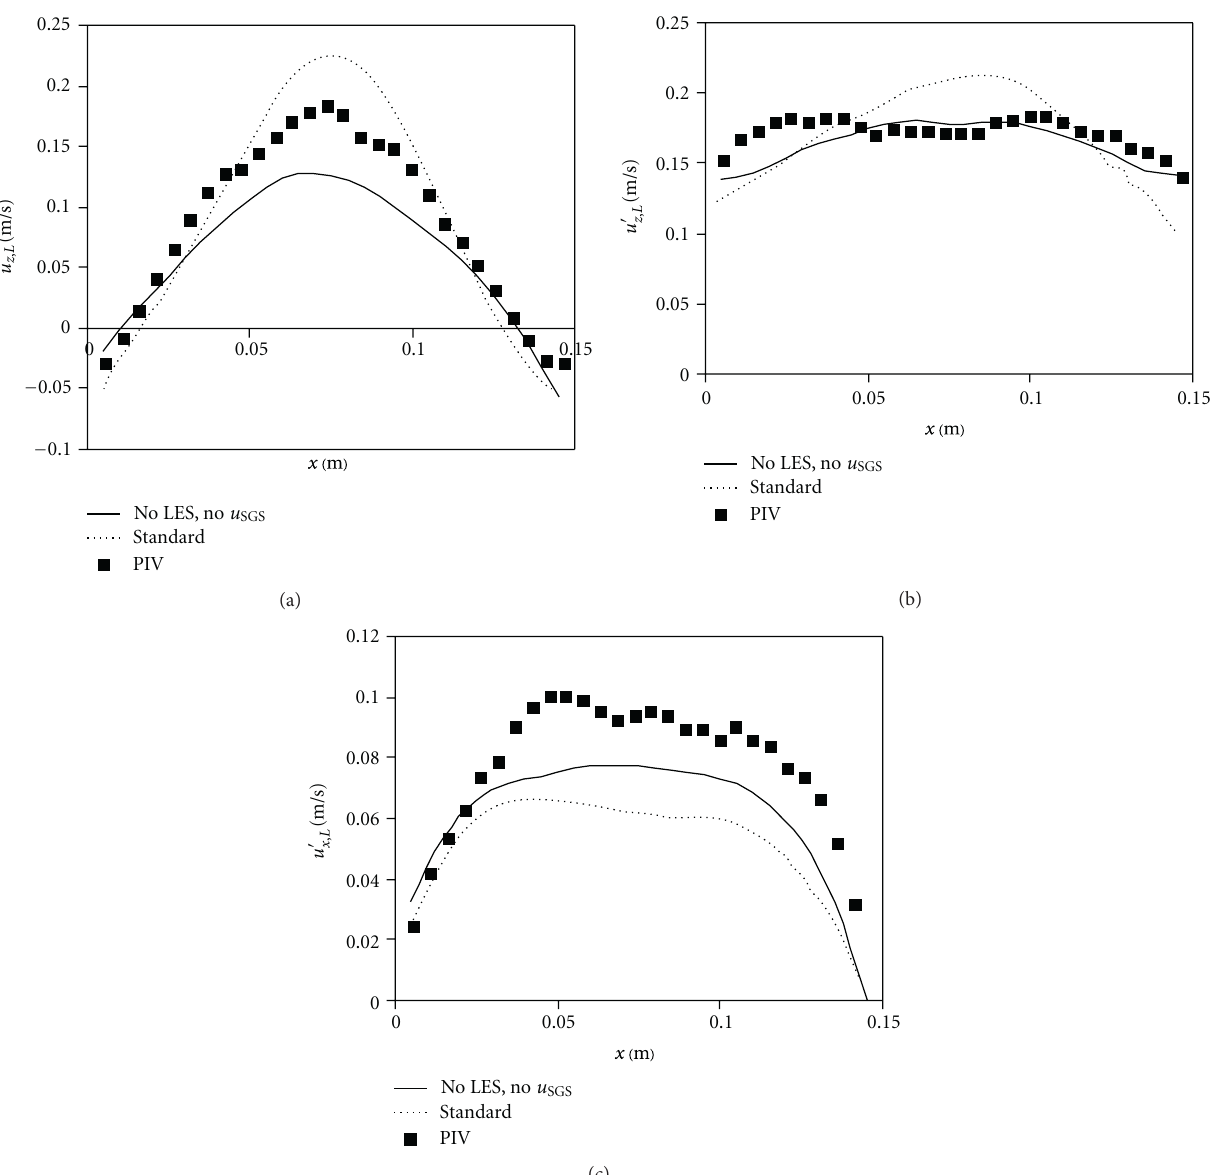
Figure 10: Comparison of the simulated and experimental liquid velocity and velocity fluctuations for cases with and without SGS model at a height of 0.255 m and a depth of 0.075 m. Effect of the SGS model (from Van den Hengel et al. [31]).